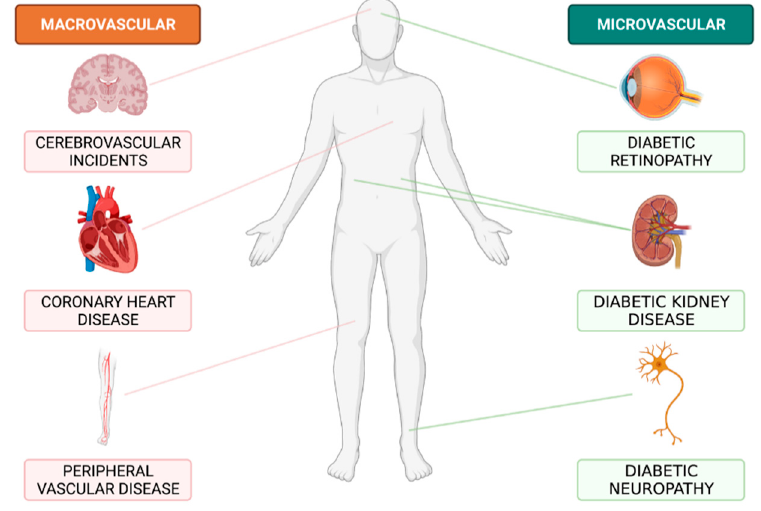
Figure 1. Long-term major complications of diabetes mellitus. Created with Biorender.com.